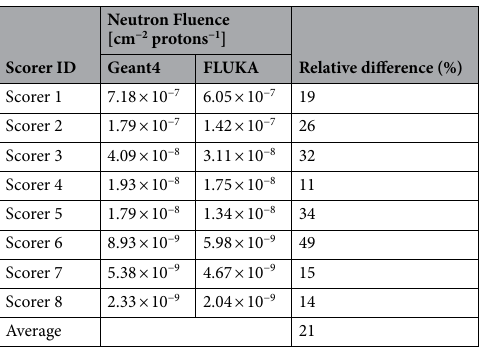
Table 4. Intercomparison between Geant4 and FLUKA MC codes using a primary source term composed by protons with energies ranging from 10 to 75 MeV. Neutron fluence results are given in cm −2 proton −1 for each scored position. The last column shows the ratio between the results of the two codes.